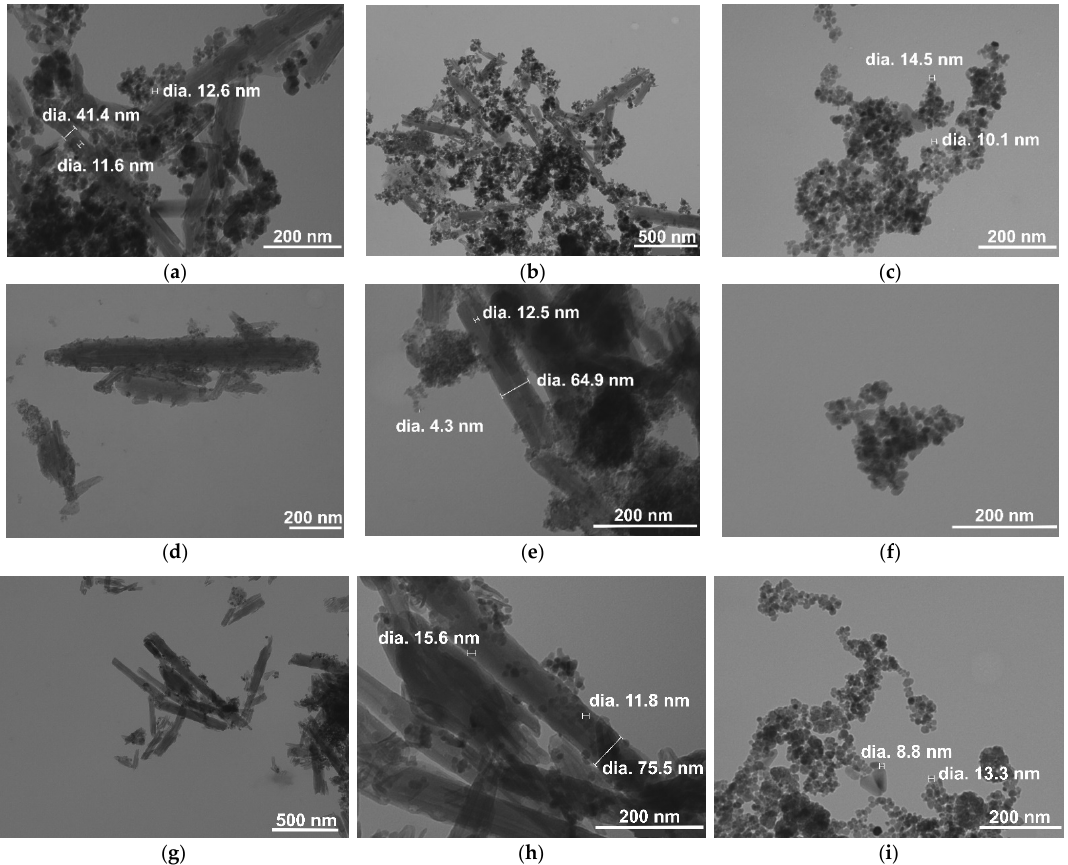
Figure 4. TEM images of the HNT/Fe 3 O 4 and magnetite samples. HNT/Fe 3 O 4 -C at magnifications of ( a ) 150 kX and ( b ) 50 kX: Fe 3 O 4 -C ( c ) at 150 kX; HNT/Fe 3 O 4 -H at ( d ) 100 kX and ( e ) 200 kX; Fe 3 O 4 -H ( f ) at 200 kX; HNT/Fe 3 O 4 -SG at ( g ) 50 kX and ( h ) 200 kX; Fe 3 O 4 -SG ( i ) at 150 kX. The Fe 3 O 4 -C sample (chosen as reference of the magnetite samples) exhibits a zeta- potential of − 7.16 mV, comparable to the literature values [48]; this value is not sufficient to achieve a stable suspension, and justifies particle aggregation (see TEM and DLS re- sults).